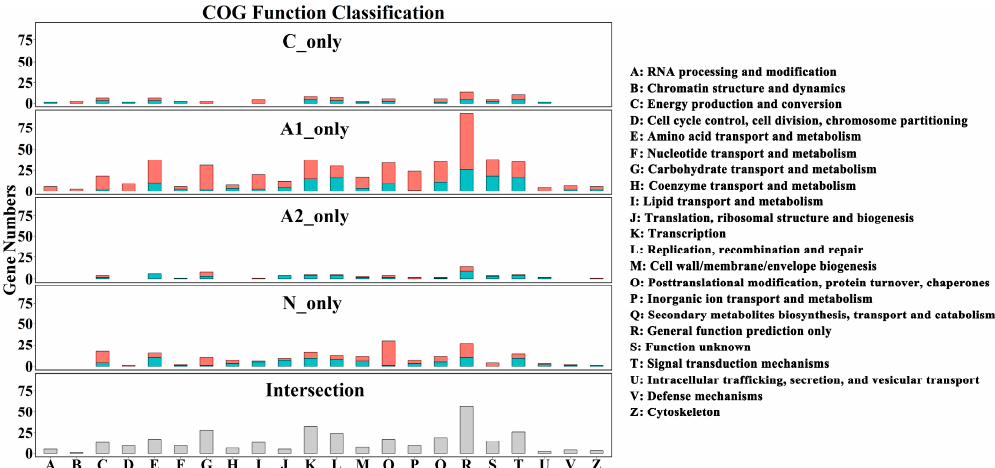
Figure 4. Functional classification of differentially expressed genes (DEGs) in C_only, A1_only, A2_only, N_only, and intersections of DEG sets of A1, A2, C, and N based on clusters of orthologous groups of proteins (COG) annotation. C_only: DEGs only found in the Control35 vs. Control33; A1_only: DEGs specifically present in ABA1000 vs. Control33; A2_only: DEGs specifically present in ABA500 vs. Control33; N1_only: DEGs specifically present in NAA200 vs. Control33. Red and cyan bars, respectively, represent the number of up-regulated and down-regulated genes in the treated grape berries of the E-L 35 stage (ripening initiation), compared to Control35.